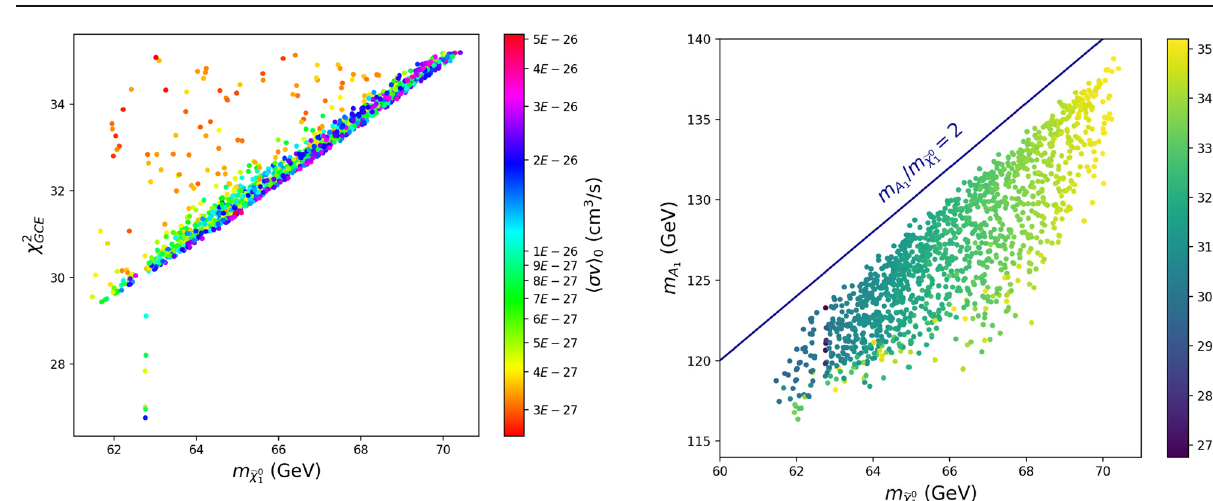
versus m A with 1 1 / m = (cid:2) χ 0 1 1